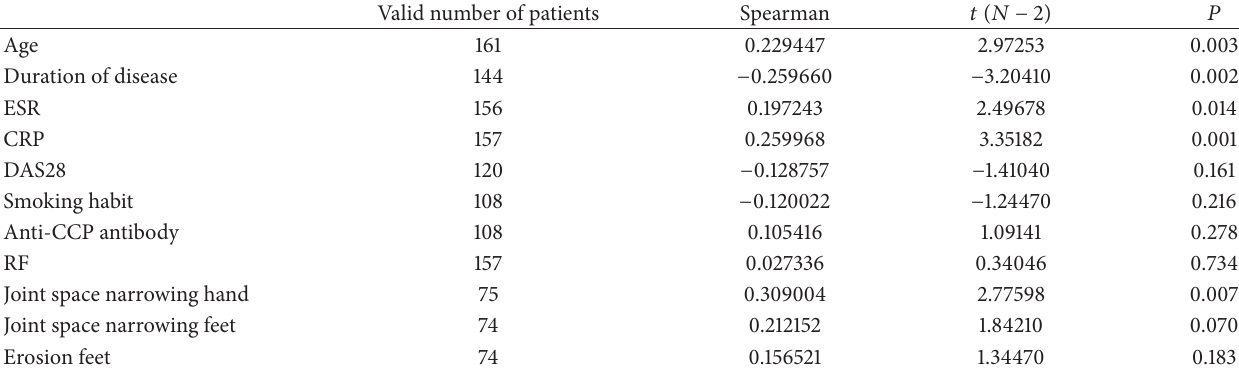
Table 4: Correlation of anti-hnRNP B1 autoantibodies with clinical characteristics of patients with RA. Valid number of patients